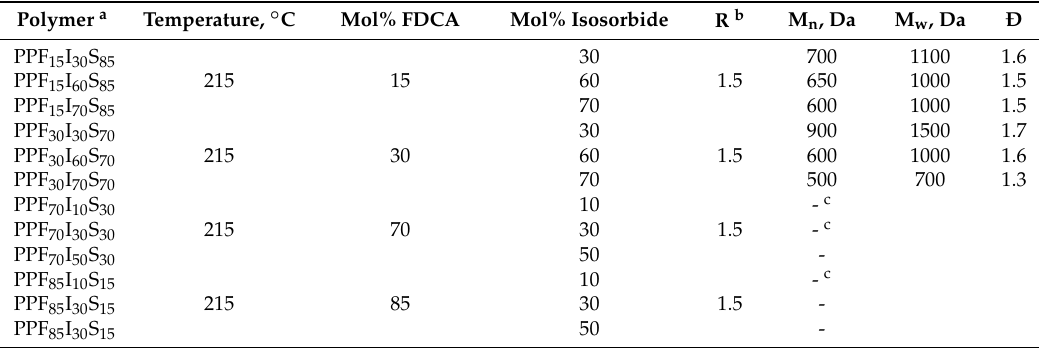
Table 1. Synthesized biomass-derived polyesters with 1,3-propanediol and isosorbide (PPFIS) . Polymer a Temperature, °C